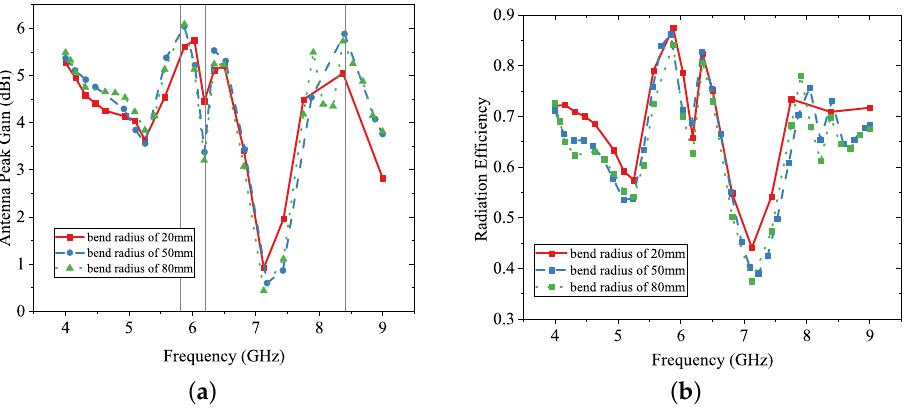
Figure 19. Antenna performance for bending tests. ( a ) Antenna peak gain; and ( b ) Antenna radiation efficiency.